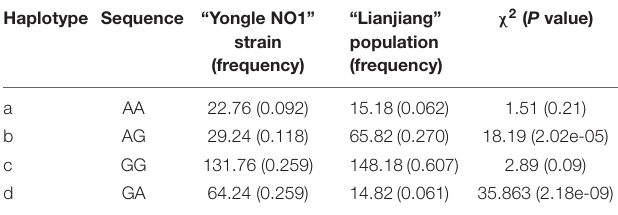
Haplotype Sequence “Yongle NO1”